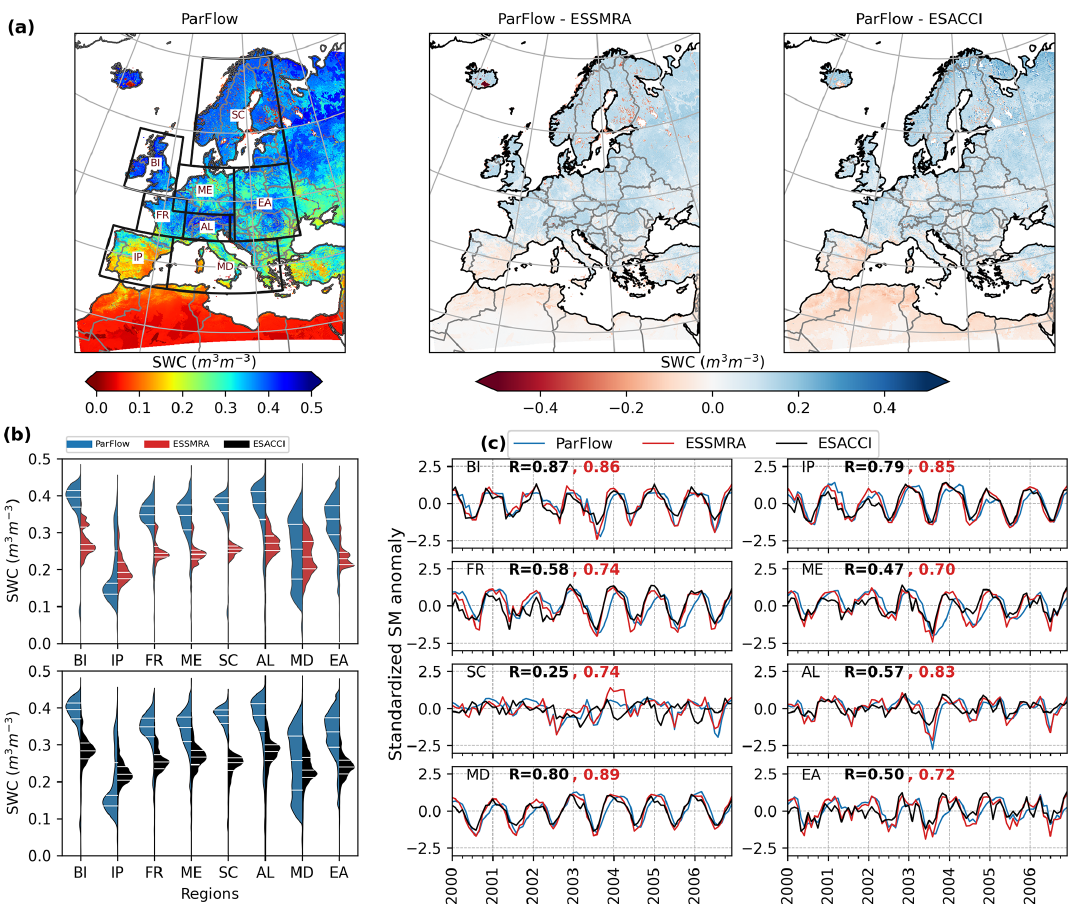
Figure 4. (a) Evaluation of time-averaged surface soil moisture (SM) simulated by ParFlow-CLM with ESSMRA and ESA CCI datasets over the time period of 2000–2006. (b) Violin plots showing comparison of spatial distribution of time-averaged surface SM simulated by ParFlow-CLM with ESSMRA (upper plot) and ESA CCI (lower plot) over PRUDENCE regions. The violin plots show the estimated kernel density distribution, as well as the median, lower and upper quartiles (white lines). (c) Comparison of spatially aggregated surface SM monthly anomalies estimated by ParFlow-CLM with ESSMRA and ESA CCI datasets for PRUDENCE regions. The SM standardized monthly anomalies in (c) were calculated by subtracting the long-term mean of the complete time series from each month and then dividing by long-term standard deviation for the simulation period of